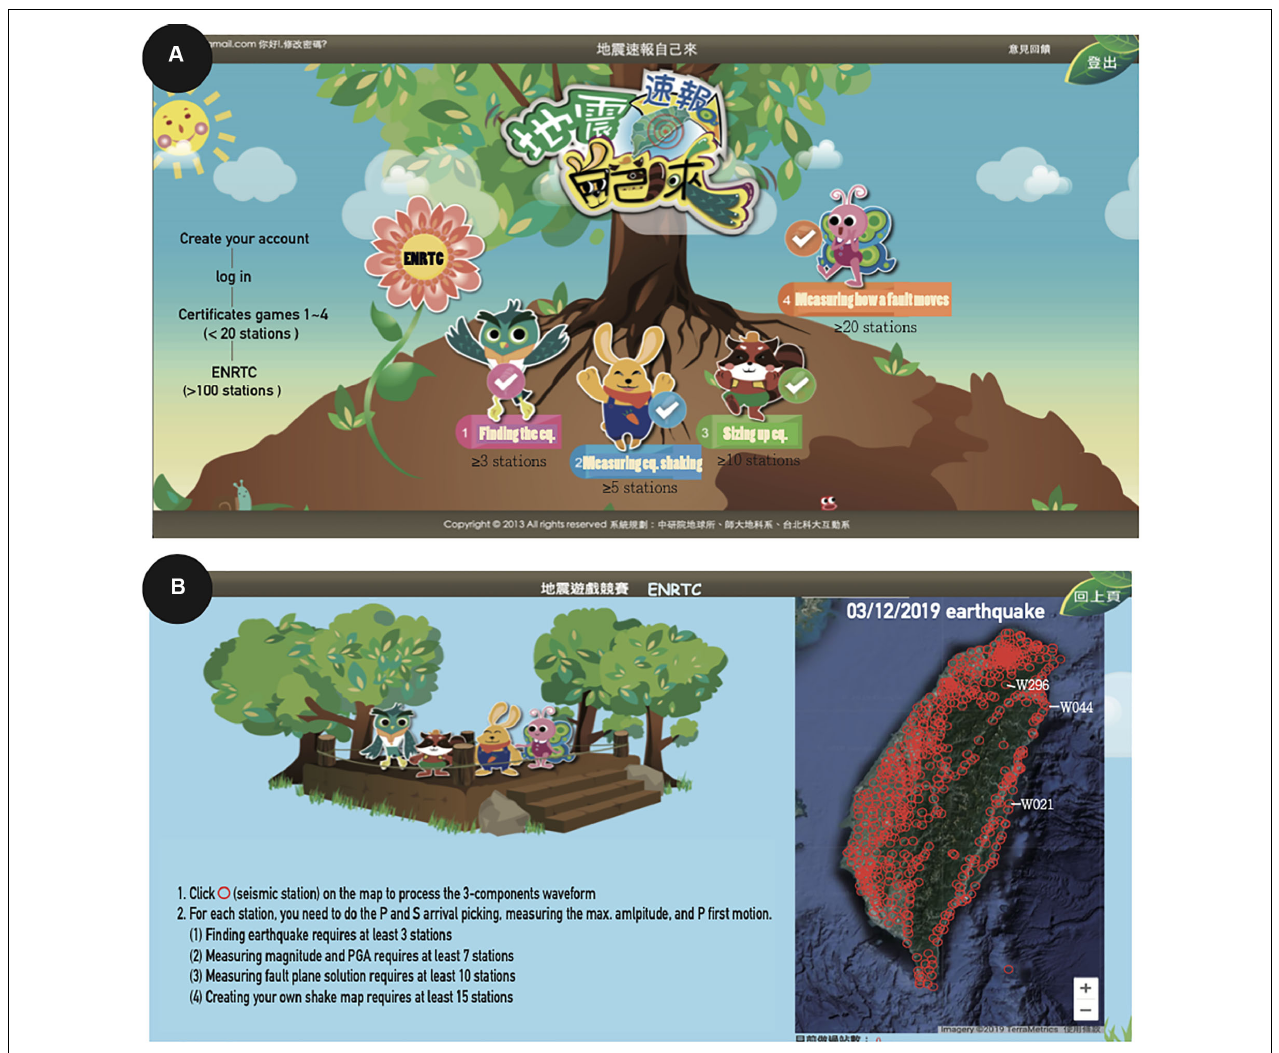
FIGURE 4 | (A) The front page of the near-real-time earthquake games competition website. Each animal represents a different game. Once the certificate is achieved, the user can enter the competition platform (EGCnrt) to contribute to real earthquake information. (B) The EGCnrt page for a selected date of March 12, 2019. Station distribution for this event is shown by the red circles. The waveforms examples indicated by text are shown in Figure 5